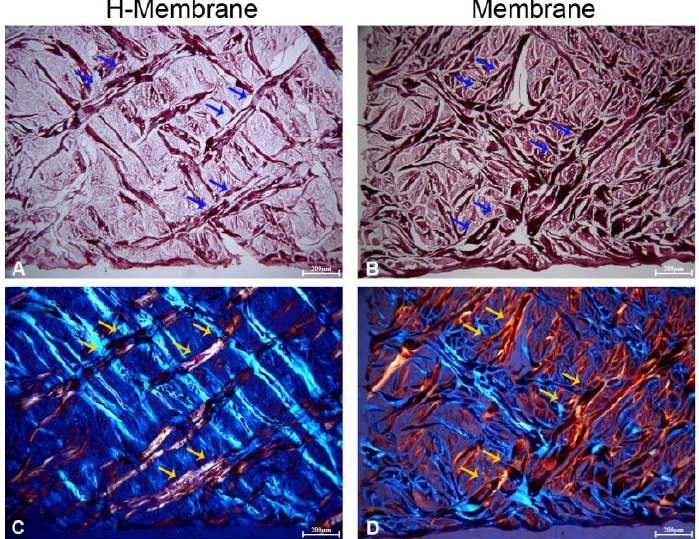
Figure 2. Characterization of the structure of the membrane by histological analysis. Hydrated membrane (H-Membrane) ( A , C ); Manufactured membrane (Membrane) ( B , D ), Magnification = 40 × . Blue and yellow arrows indicate the collagen fibers.